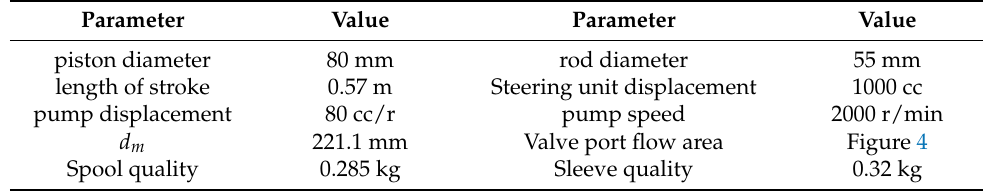
Table 1. System key component